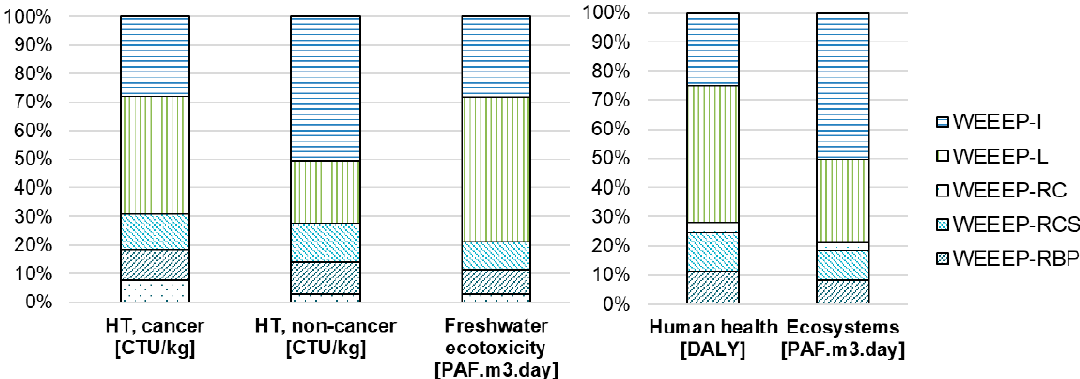
Figure 5. Environmental impacts associated with the five end-of-life scenarios (WEEEP-I, WEEEP-L, WEEEP-RD, WEEEP-RCS, and WEEEP-RBP) for 1 kg of e-plastic residues (left: USEtox mid-point results for the “human toxicity, cancer”, “human toxicity, non-cancer”, and “freshwater ecotoxicity” impact categories; right: USEtox end-point results for the “human health” and “ecosystems” damage categories.